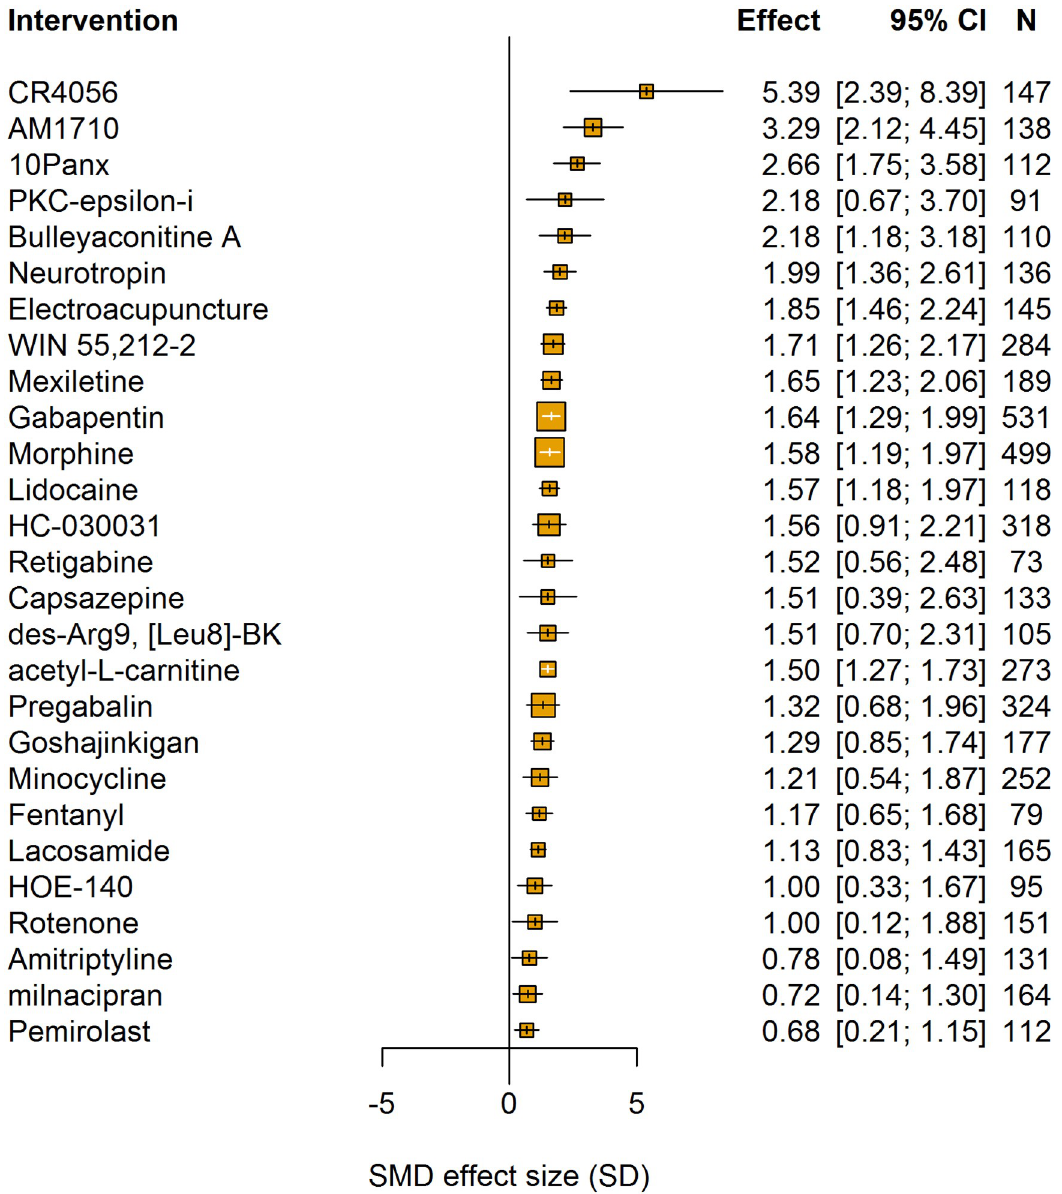
Fig 9. Intervention accounted for a significant proportion of the heterogeneity in intervention experiments using pain-related behavioural outcomes (data set 2a). Plot shows interventions with 10 or more comparisons. The size of the squares represents the number of nested comparisons that contribute to that data point, and the value N represents the number of animals that contribute to that data point.